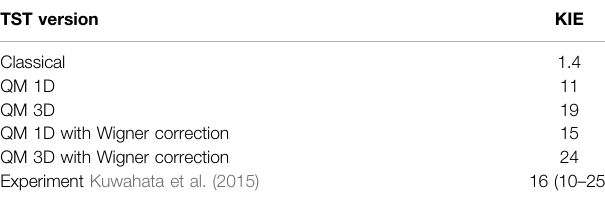
TABLE 2 | Experimental and theoretical kinetic isotope effects obtained for ASW at 10 K using various forms of harmonic TST as described in the